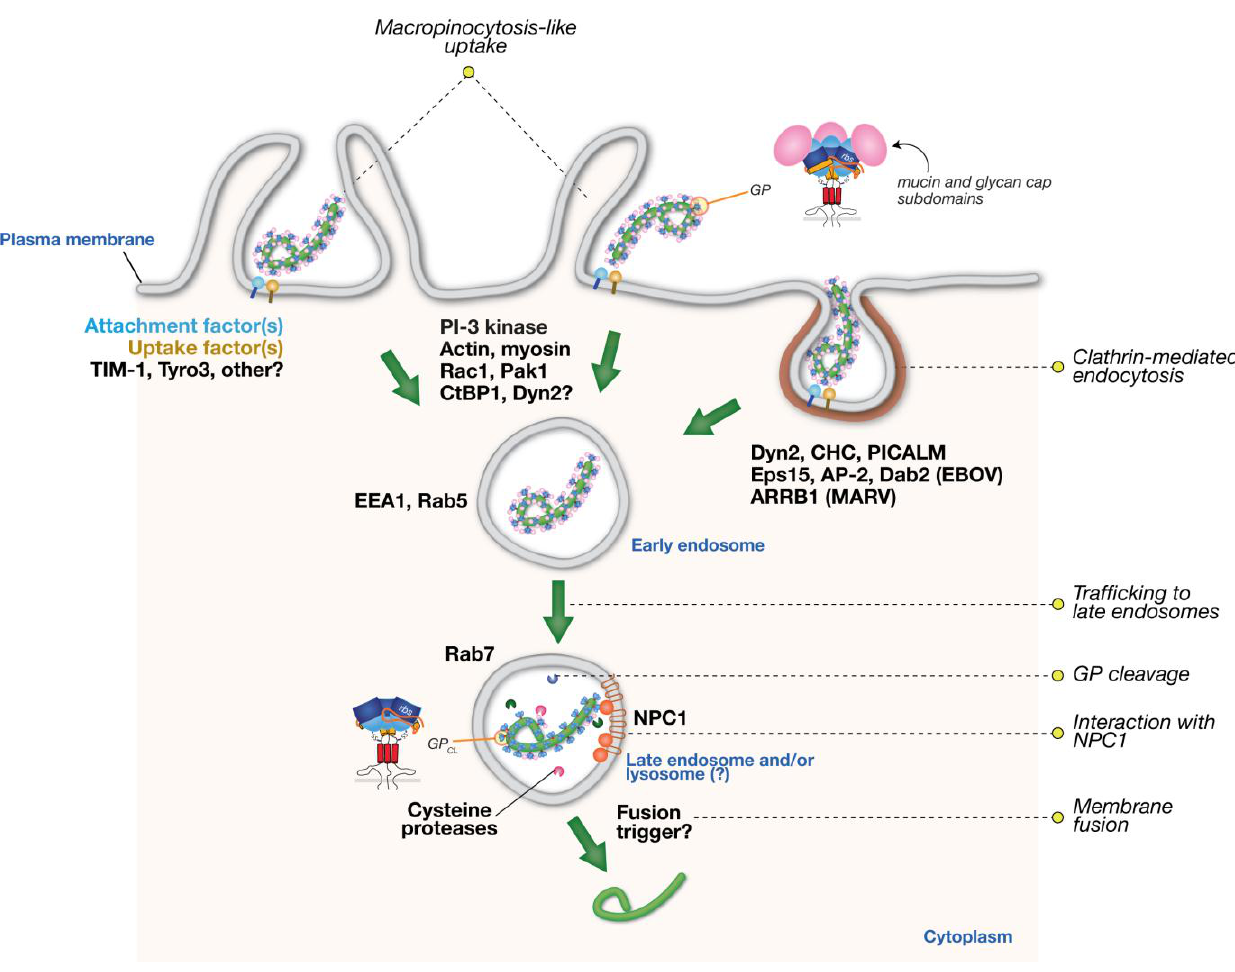
Figure 1. Schematic model of the filovirus entry mechanism with emphasis on clathrin and macropinocytic pathways for viral internalization. Distinct endocytic pathways and host factors implicated in filovirus entry are indicated. Please see the text for a more complete list of identified endocytic host factors and additional